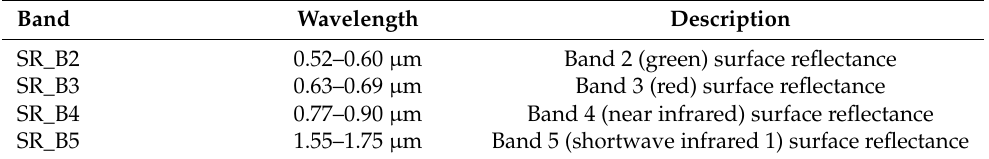
Table 1. Band combinations for monitoring plant density using Landsat 7 data.